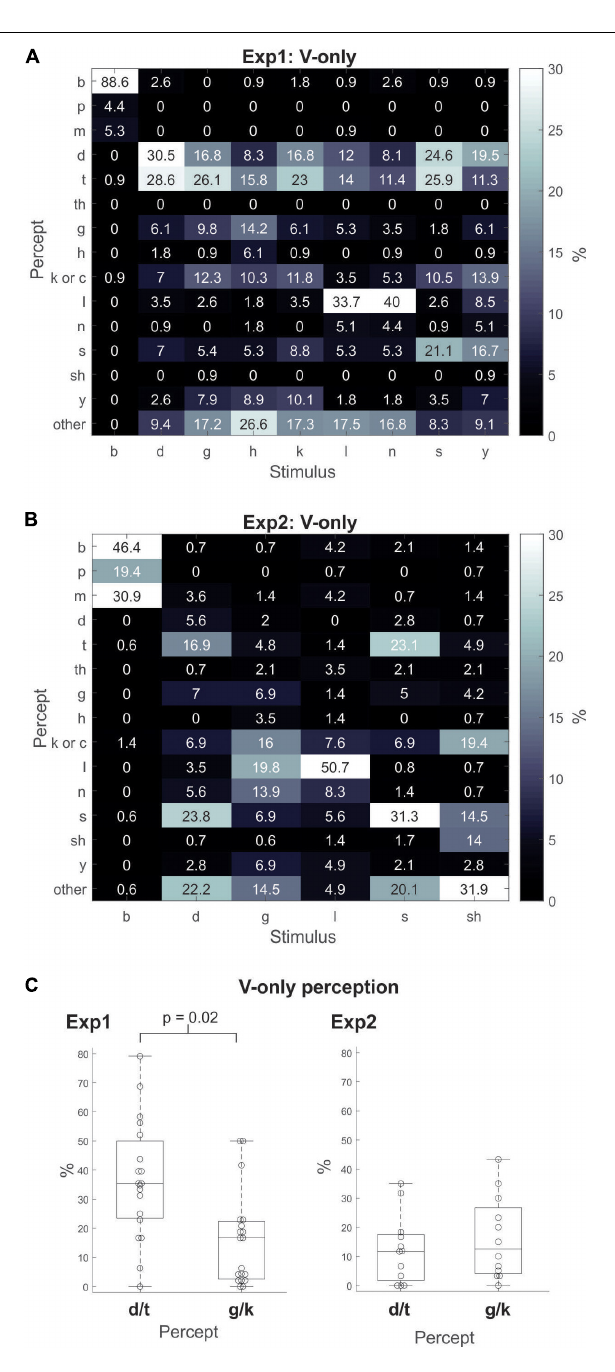
FIGURE 1 | Gray-scale matrix depicting percentages of response percepts to visual-only (V-only) CV utterances for Experiment1 (A) and Experiment2 (B) . The percentage for each percept was calculated as the percentage of responses of that percept relative to all other responses within a stimulus type (i.e., for each viseme). (C) For the visual-only (V-only) CV utterances in Experiment1 (left) and Experiment2 (right), the percentage of responses for the “da”/“ta” or “ga”/“ka” percept relative to all other responses across all visemes, except /ba/. The boxplots indicate the median (the horizontal line inside of the box), the 25 and 75th percentiles (the box’s bottom and top edges, respectively), and the whiskers indicate the range of the individual data points. (Note that there were no